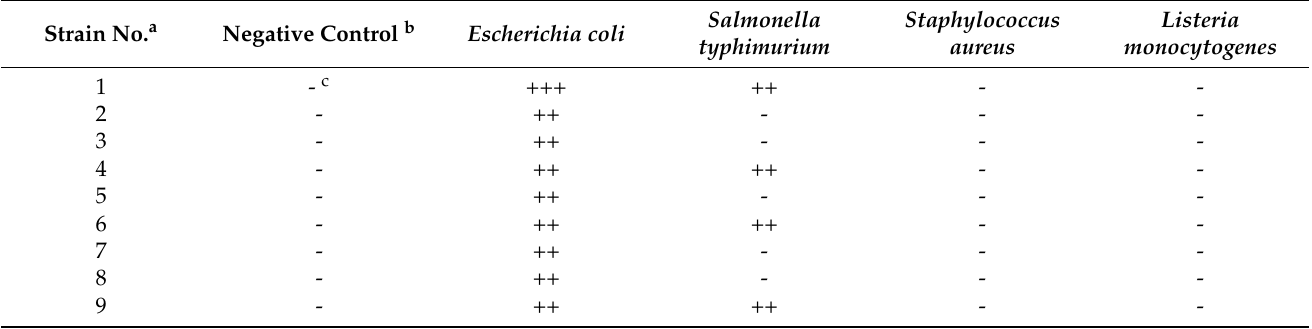
Table 4. Comparison of antimicrobial activities of long-term fermented Godulbaegi kimchi.